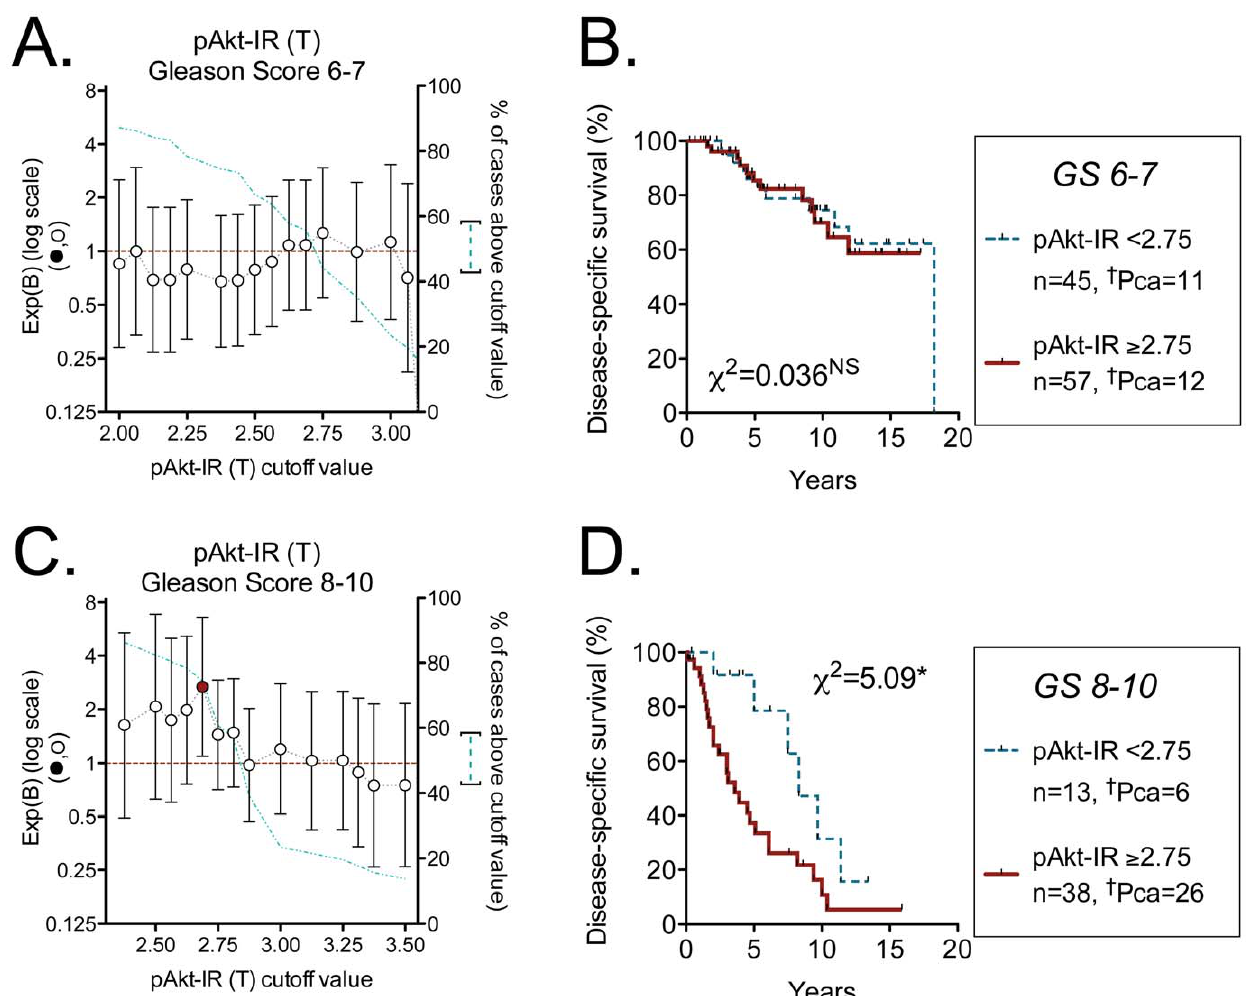
Figure 4. Prognostic significance of tumour and non-malignant pAkt-IR for cases who were followed by expectancy. Panel A and B are for cases with Gleason scores 6–7 (n=102); Panels C and D are for cases with Gleason scores 8–10 (n=51). The Exp(B) values obtained from Cox proportional-hazards regression analyses (Panels A and C) and the Kaplan-Meier plots (Panels B and D) were determined as described in the legend to Fig. 2. The k¸ 2 values are for the log-rank (Mantel-Cox) tests, with the P values shown: *P , 0.05, NS P . 0.8.